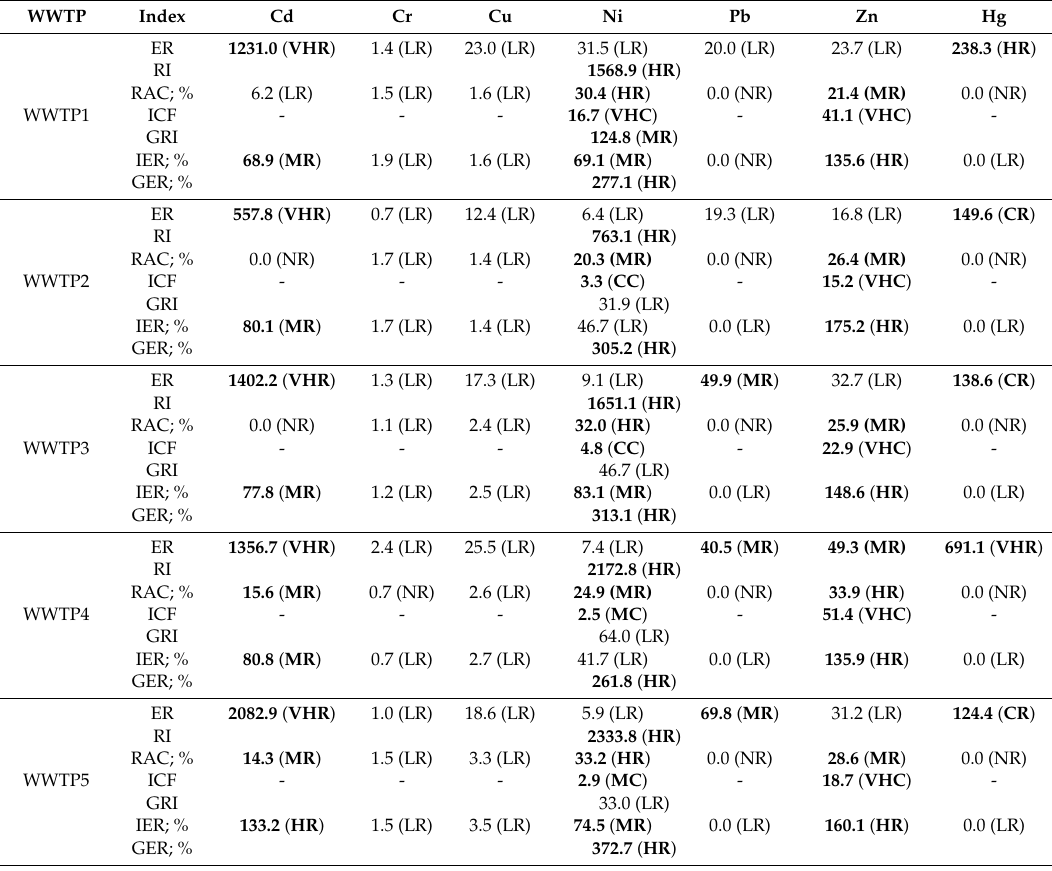
Table 8. Ecological risks of the heavy metals in the dewatered and / or hygienized sewage sludge samples. WWTP